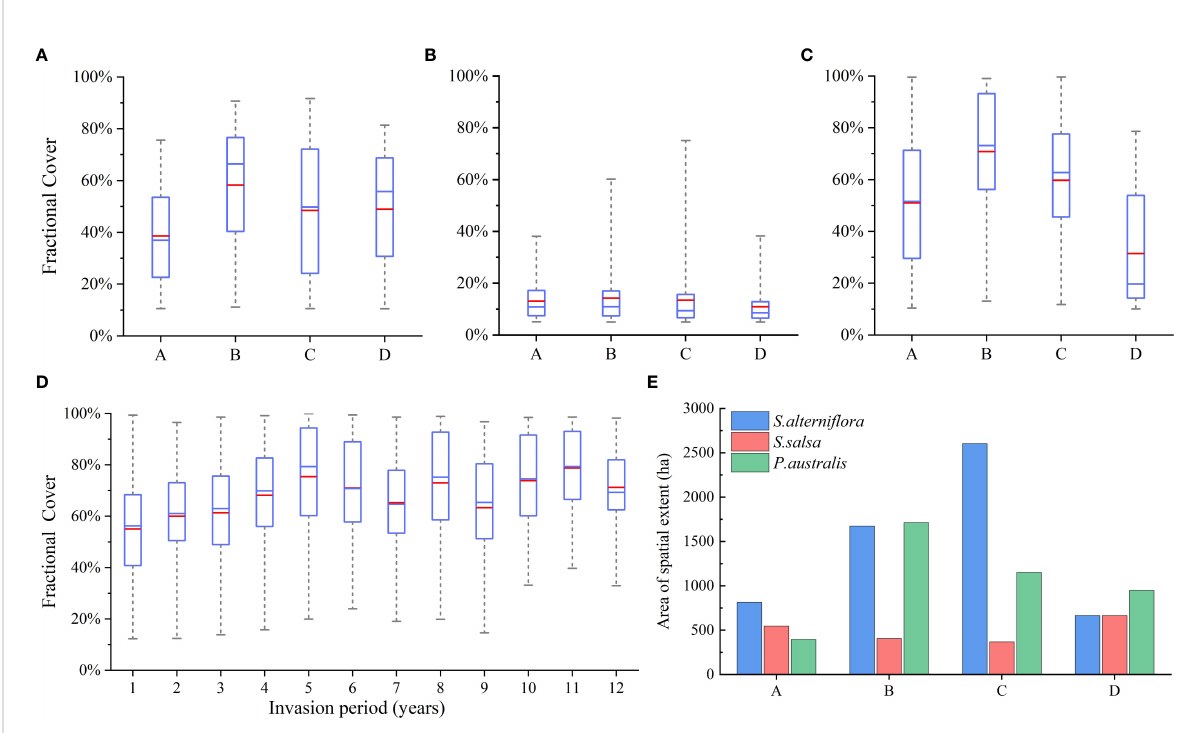
FIGURE 9 Zonal statistics of salt marsh vegetation. Box and whiskers plots of the fractional cover of (A) P.australi s, (B) S.salsa , (C) S.alterni fl ora within different zones. (D) The box and whiskers plots of the fractional cover of S.alterni fl ora with different invasion years. And (E) The spatial extent area of different salt marsh vegetations within different zones. The whiskers boundaries are 25th and 75th percentile, and the blue and red lines represent the median and mean values,